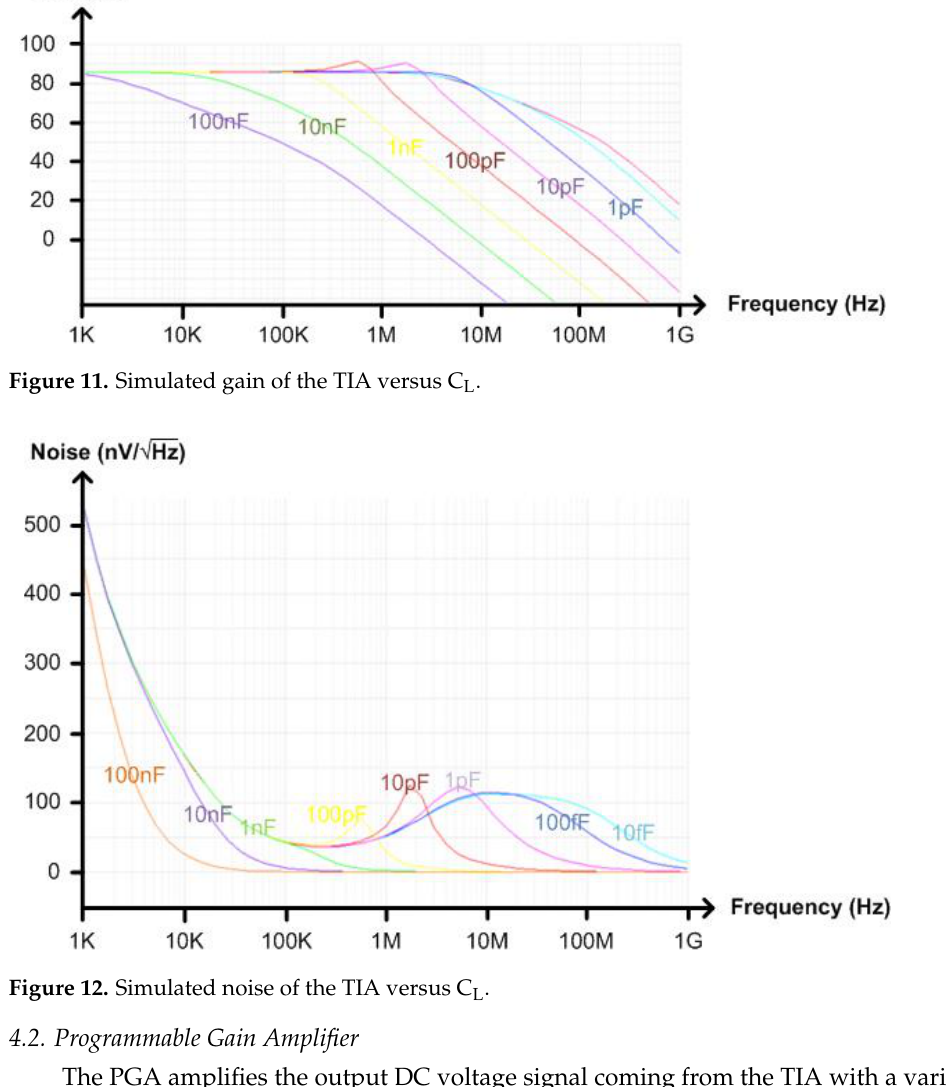
Figure 10. Schematic of the TIA.